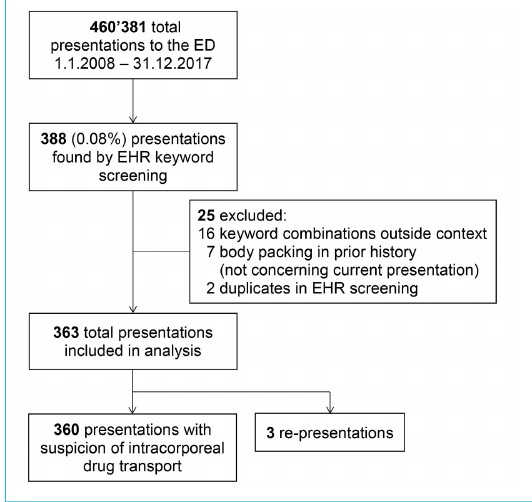
Figure 1: Patient selection with total ED presentations between January 1st 2008 and December 31th 2017, keyword screening of electronic health records (EHRs), exclusions and inclusion in final